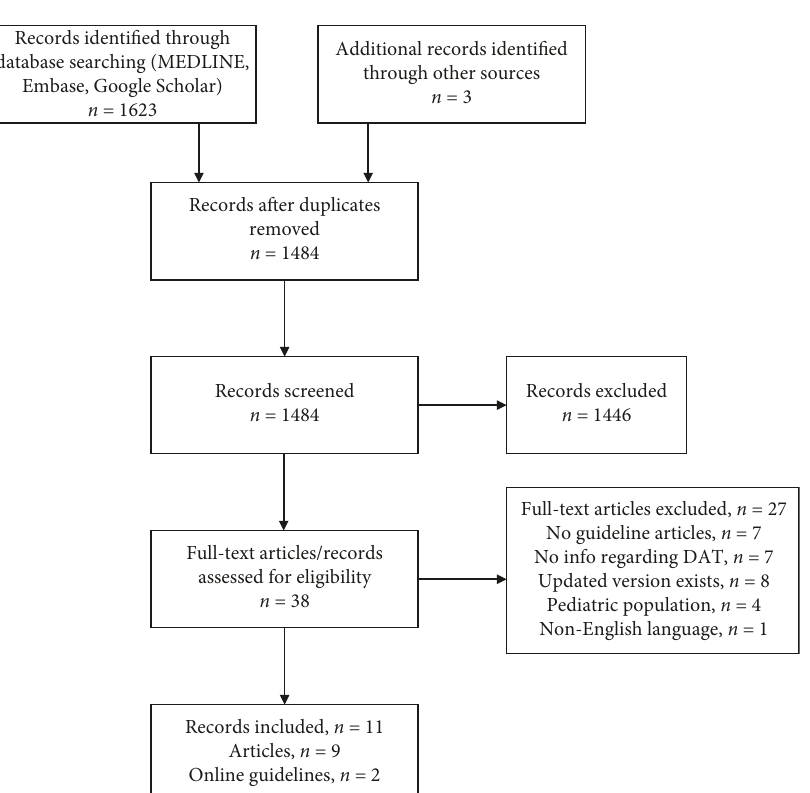
Figure 1: PRISMA flow diagram mapping the guideline article selection